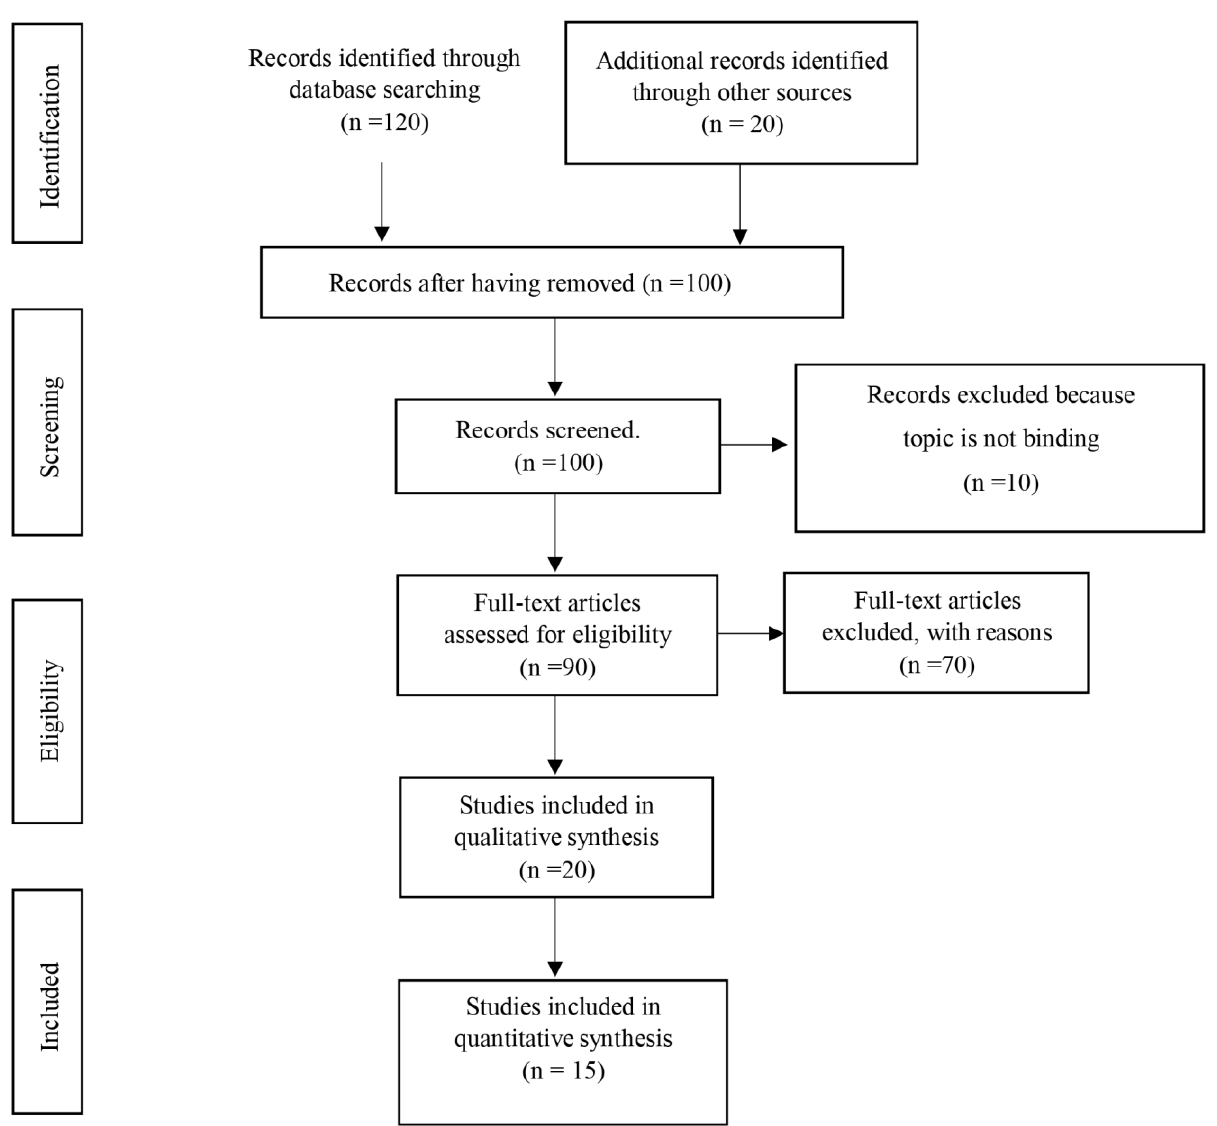
Figure 1. PRISMA 2020 flow diagram.